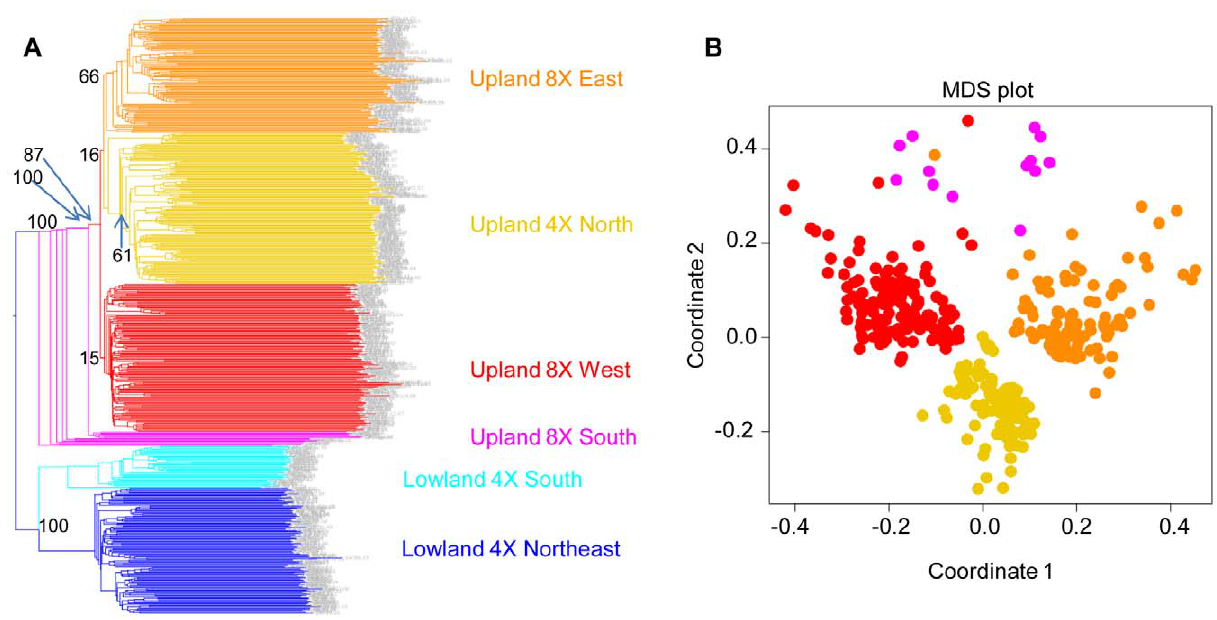
Figure 7. Upland 4 6 arose from 8 6 . (A) A NJ tree of 29,221 markers. The lowland clade is the outgroup. (B) Multiple dimensional scaling (MDS) plot of the upland ecotypes.